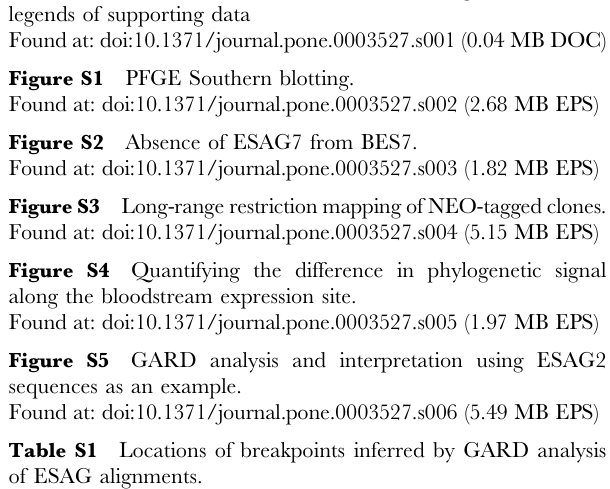
legends of supporting data